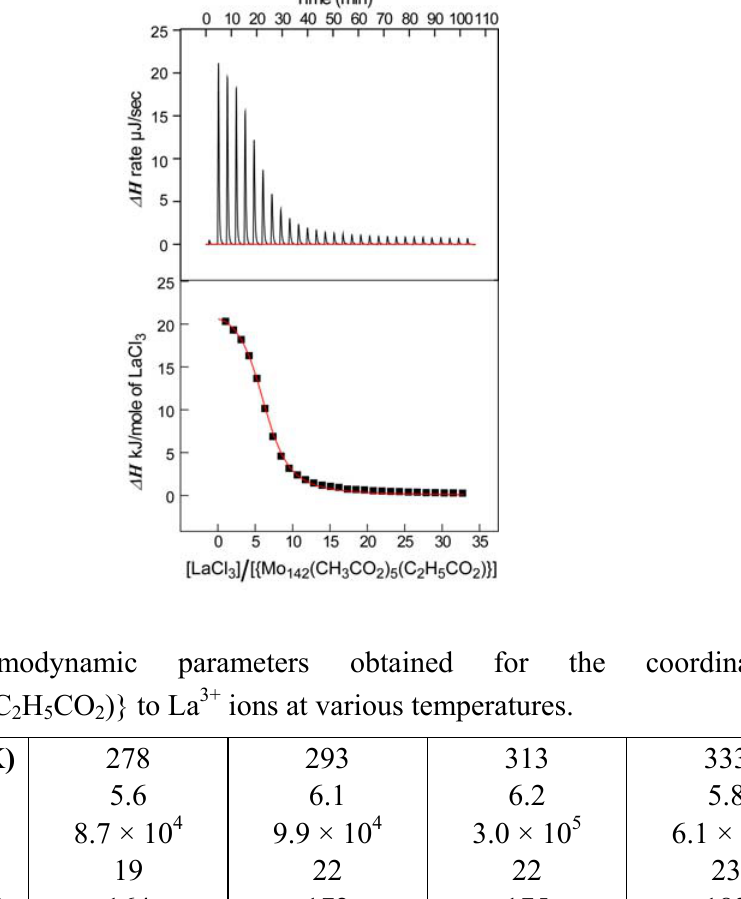
. Diagram of the enthalpy produced in each of injections of LaCl 3